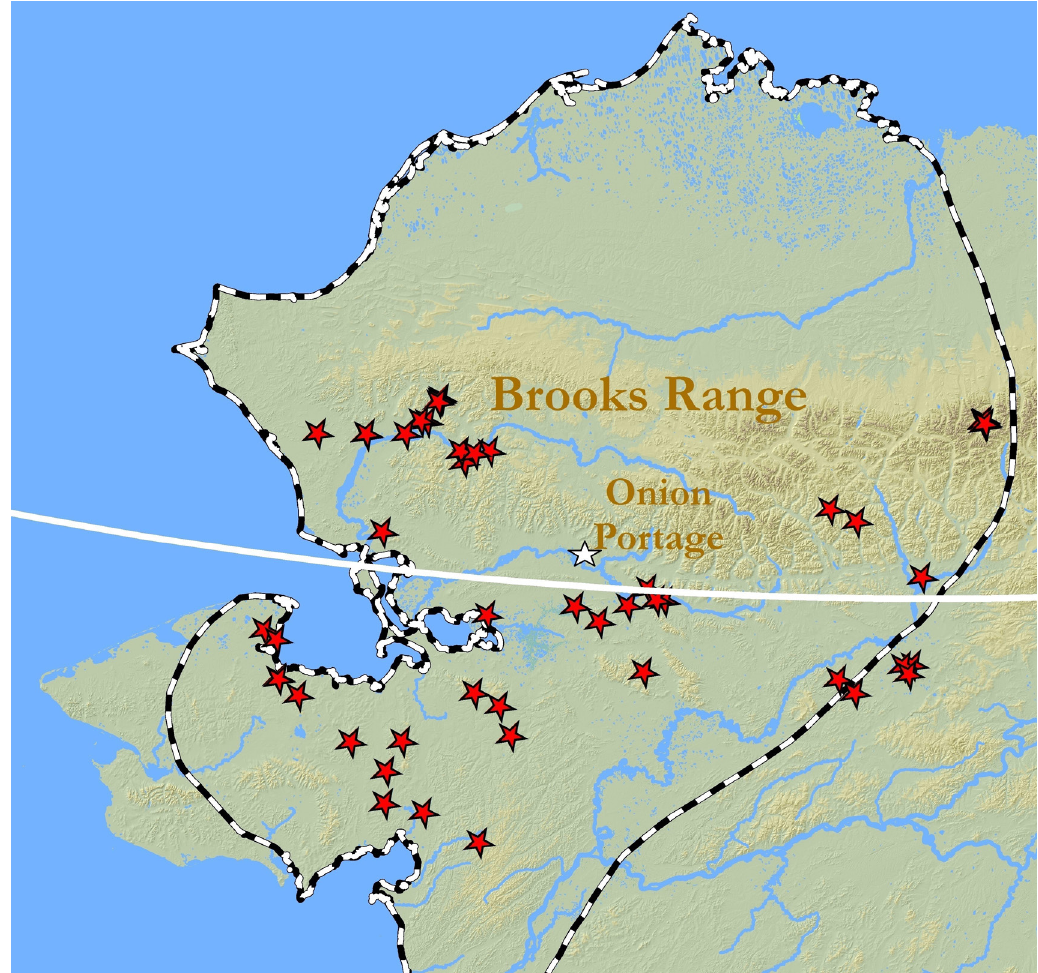
Figure 1. Study area map indicating the locations of fecal sample collection sites in northwest Alaska, 2010-2013. Red stars indicate late winter sites and the white star is Onion Portage where all early fall collections were made. The black and white dashed line indicates the approximate boundary of the Western Arctic Herd’s range (courtesy of the Alaska Department of Fish and Game). The white line indicates